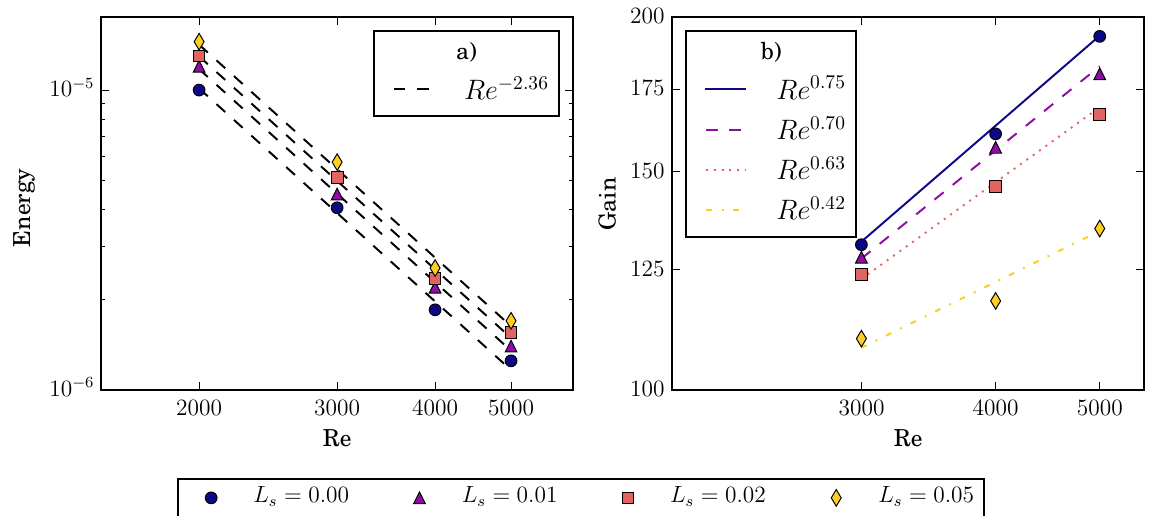
Figure 10. Scaling law for the initial energy ( a ) and the energy gain ( b ) associated with the hairpin-like nonlinear optimal perturbation for the channel flow with different values of the slip length reported in the